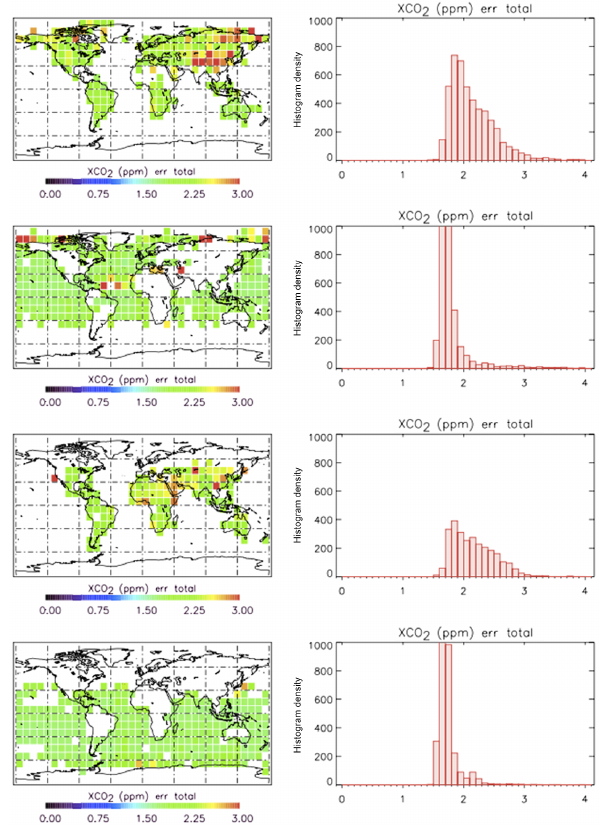
Figure 6. Total error. Top: June, land; second row: June, ocean; third row: Dec. land; bottom: Dec.,